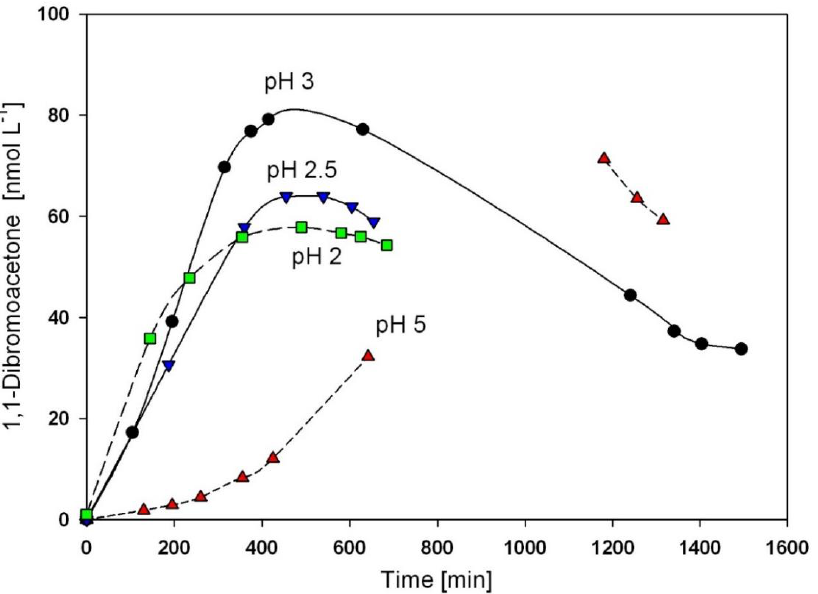
Figure 8. Concentration time profiles for 1,1-dibromoacetone, determined with the extraction method in the pH range from 2 to 5 in a semi-batch reactor under constant irradiation and an O 3 dose of 3.1∙10 −6 mol min −1 . Concentrations in the liquid phase were: c(HA) = 33 mg L −1 , c(Cl − ) = 0.86 mol L −1 and c(Br − ) = 0.017 mol −1 corresponding to bromide/chloride ratio of 1/50. An experiment at pH 7 (not shown) with a bromide/chloride ratio of 1:100 (c(HA) = 40 mg L −1 , c(Cl − ) = 0.86 mol L −1 ), c(Br − ) 8.5 × 10 −3 mol L −1 ) delivered up to 60 nmol L −1 of bromoacetone and 18 nmol L −1 of 1,1-dibromobenzene after 1400 min of irradiation.